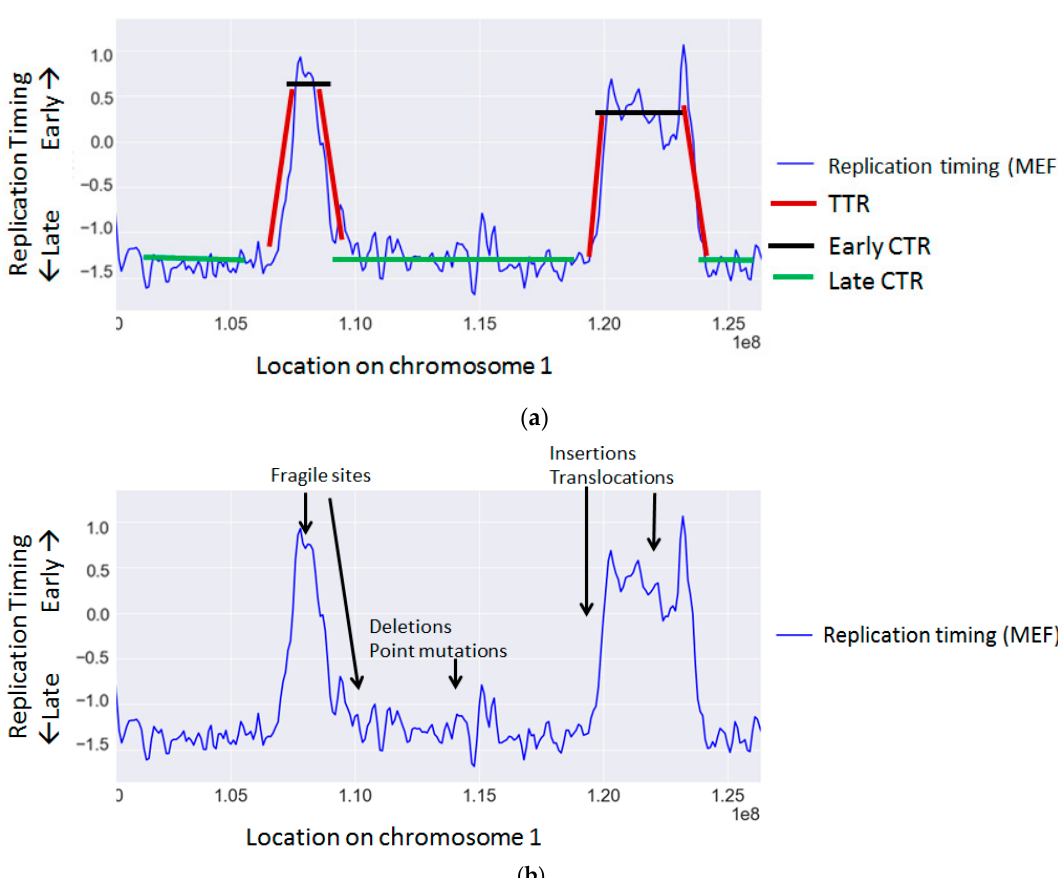
Figure 1. Representative replication timing profiles. ( a ) An example of a replication timing map of mouse embryonic fibroblasts (MEF) [111] for a 2 Mb-sized region labeled by region type: TTR (timing transition region) or CTR (constant timing region); ( b ) The same replication timing map with annotation of the regions prone to various types of mutations.